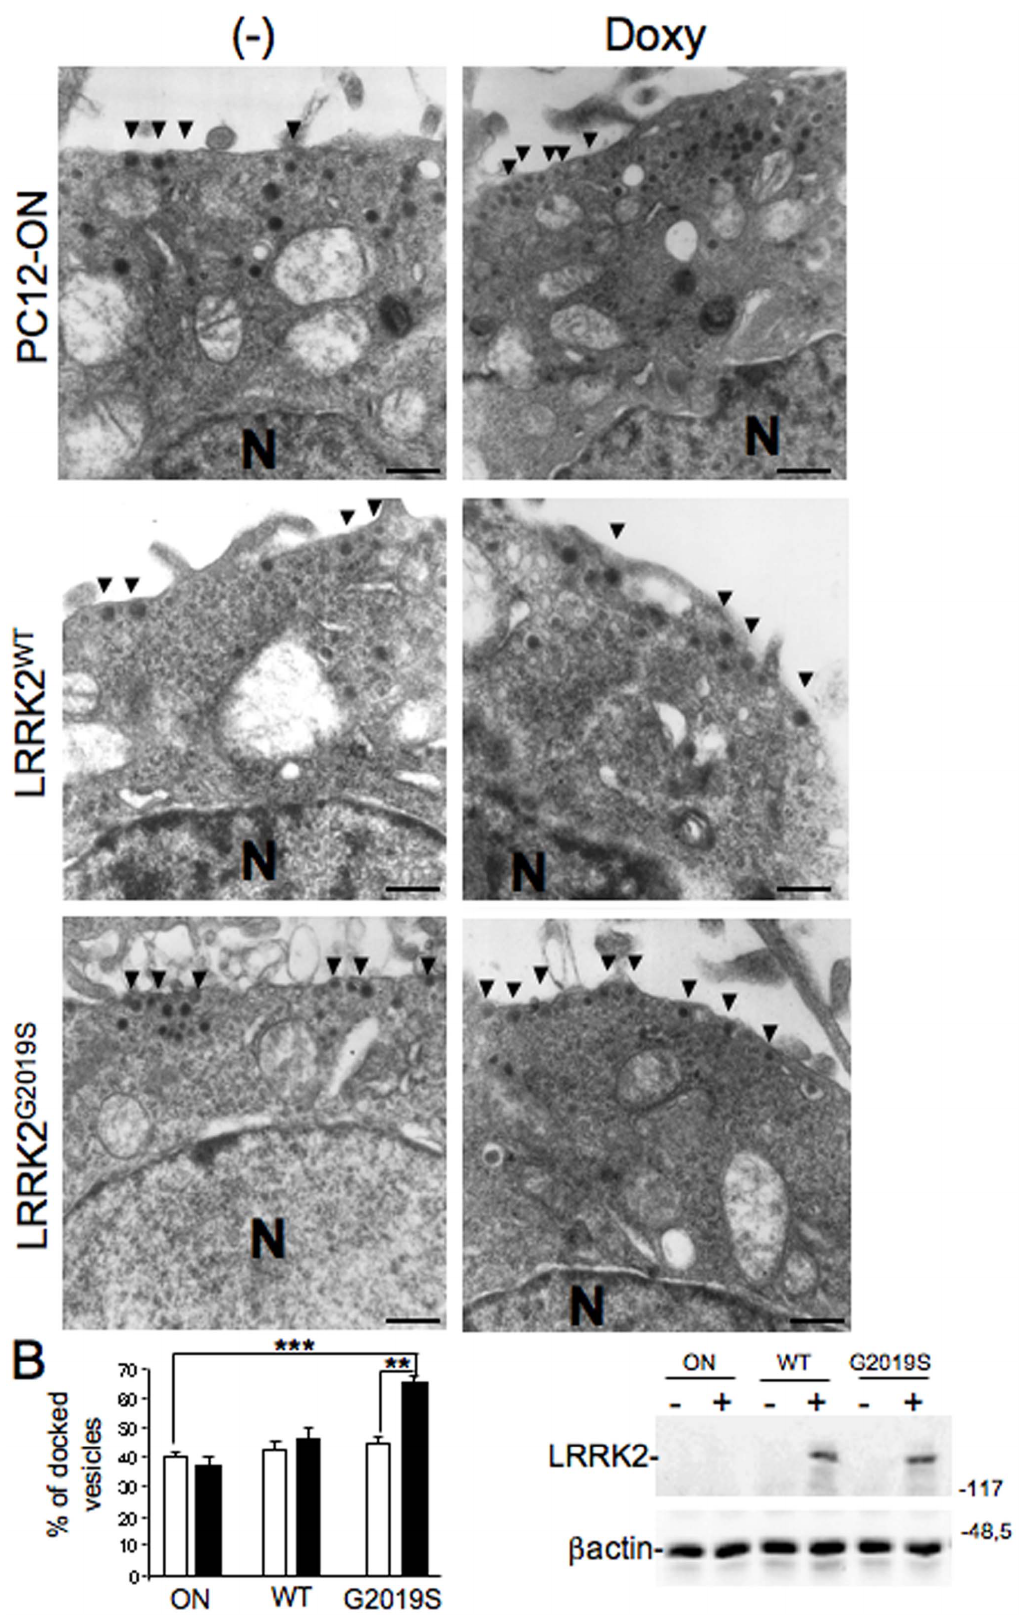
Figure 5. Effect of LRRK2 G2019S expression on vesicle distribution. (A) Transmission electron micrographs of PC12-ON or PC12-LRRK2 WT or PC12-LRRK2 G2019S cells untreated ( 2 ) or treated with 0.2 m g/ml doxycycline for 48 h ( + ). Arrows point at vesicles near the membrane. N indicates the